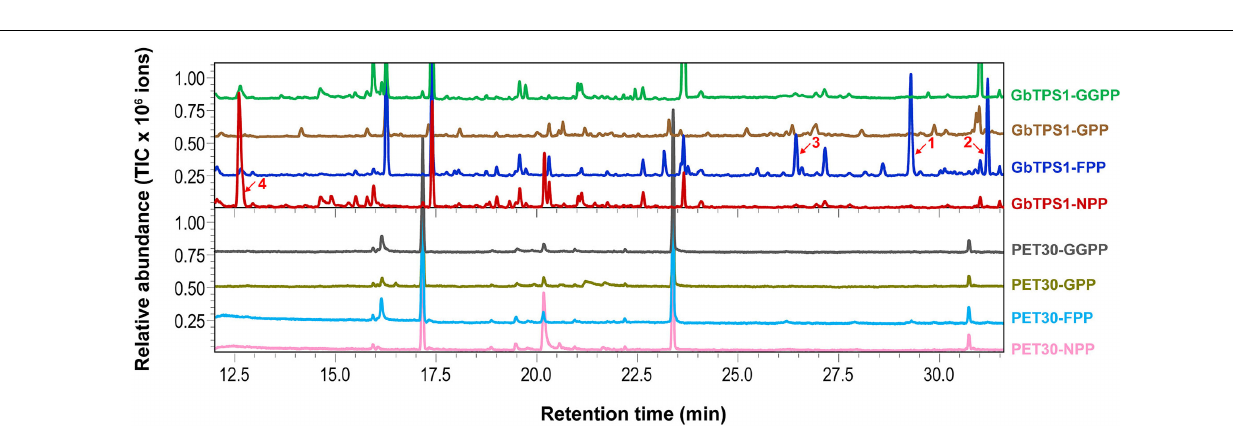
Frontiers in Plant Science |